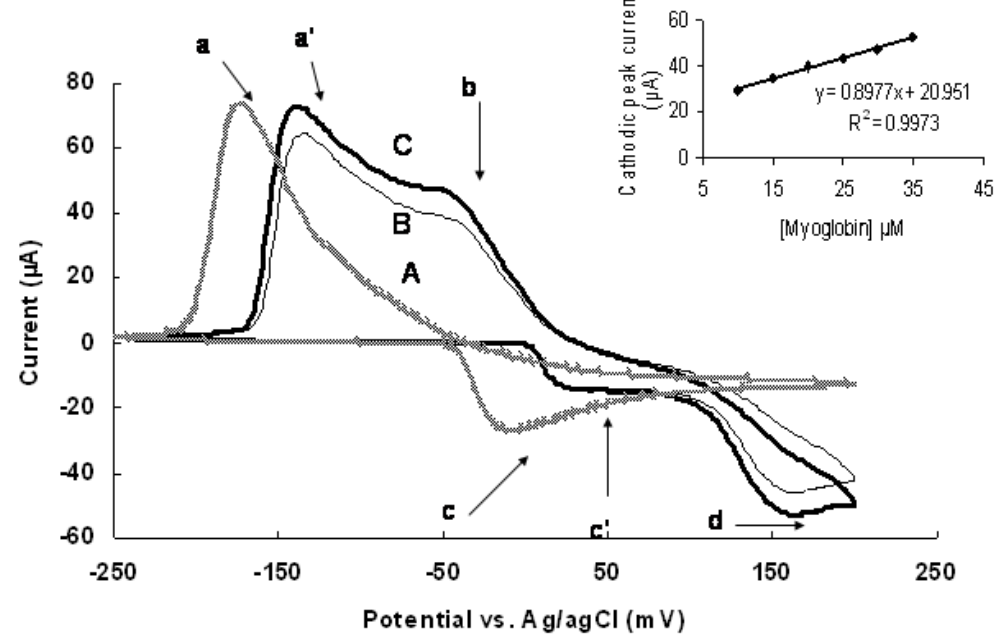
Figure 3. Cyclic voltammograms of silver electrode in a solution of 0.1 M KNO